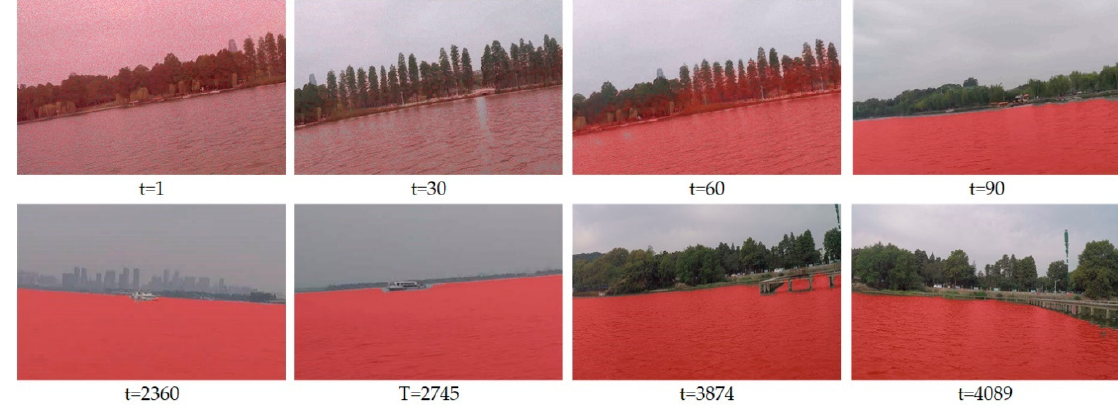
Figure 6. Segmentation performance during the online learning.